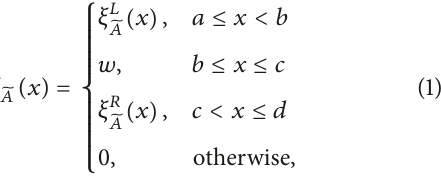
̃𝐴 󸀠 𝑖 is the image of